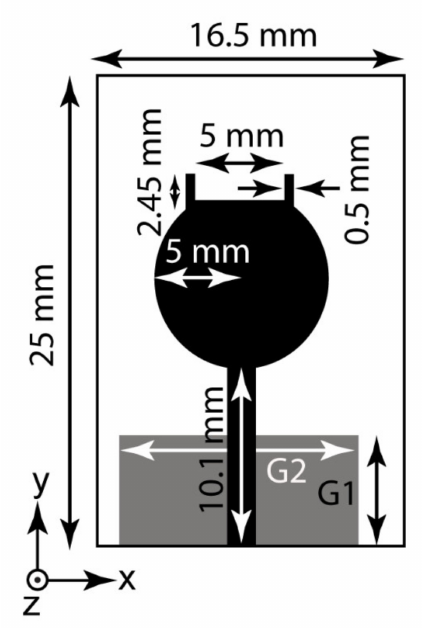
Figure 1. Diagram of the stub-loaded circular MIMO